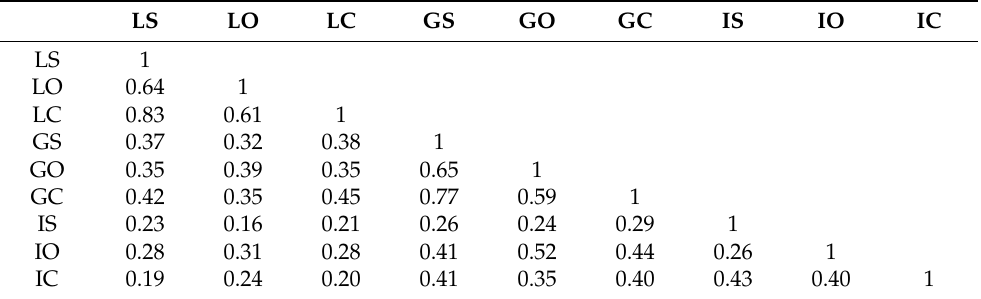
Table A1. Data from nurses.